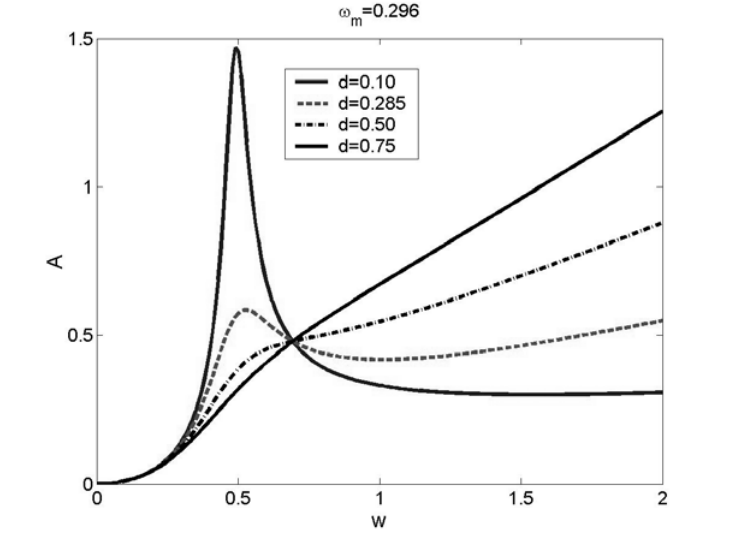
Fig. 12. Absolute engine mass